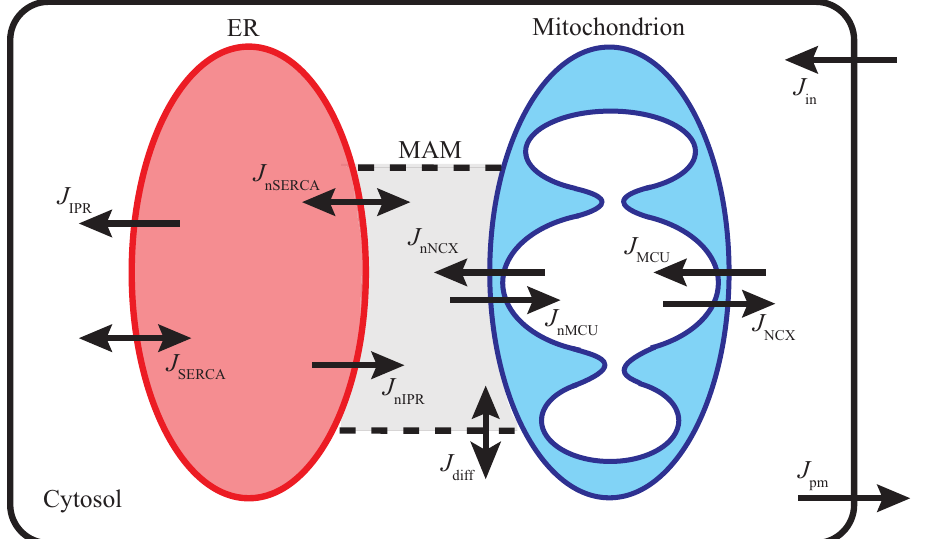
Fig 1. Schematic diagram of Ca 2+ dynamics described by the model. The ER releases Ca 2+ to the cytosol and MAM; the fluxes are denoted as J IPR and J nIPR , respectively. The cytosolic Ca 2+ is pumped back into the ER lumen via SERCA ( J SERCA ), and the Ca 2+ in MAM are also pumped back into the ER ( J nSERCA ). Mitochondria uptake Ca 2+ from the cytosol ( J MCU ) and MAM ( J nMCU ), and mitochondrial Ca 2+ is exchanged with Na + in the cytosol ( J NCX ) and MAM ( J nNCX ). Ca 2+ can freely diffuse between the cytosol and MAM ( J diff ). The total Ca 2+ concentration is regulated by the plasma membrane influx ( J in ) and efflux ( J pm